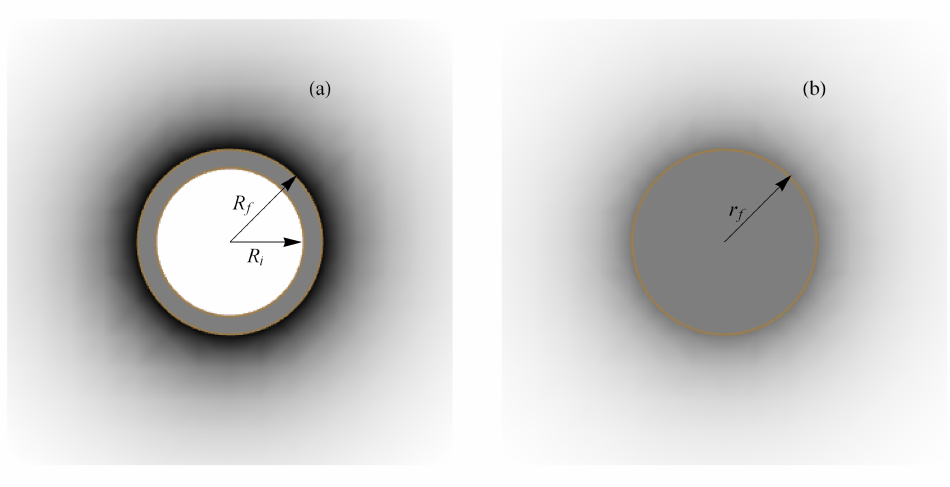
Figure 1. ( a ) Schematic picture of an eicheon in the metric (56), taking into account a vacuum polarization in the form of dark radiation; ( b ) an eicheon in the metric (48) looks similar to a solid sphere with a “dark radiation” of the finite energy density in the